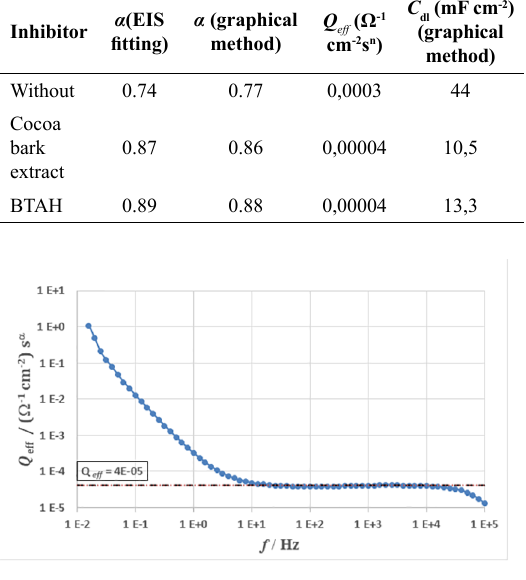
Figure 7. Effective CPE coefficient (Q for CS - ASTM 1020 steel after immersion for 90 min in 18.23 g L -1 HCl solution in the presence of 1.112 g L -1 cocoa bark